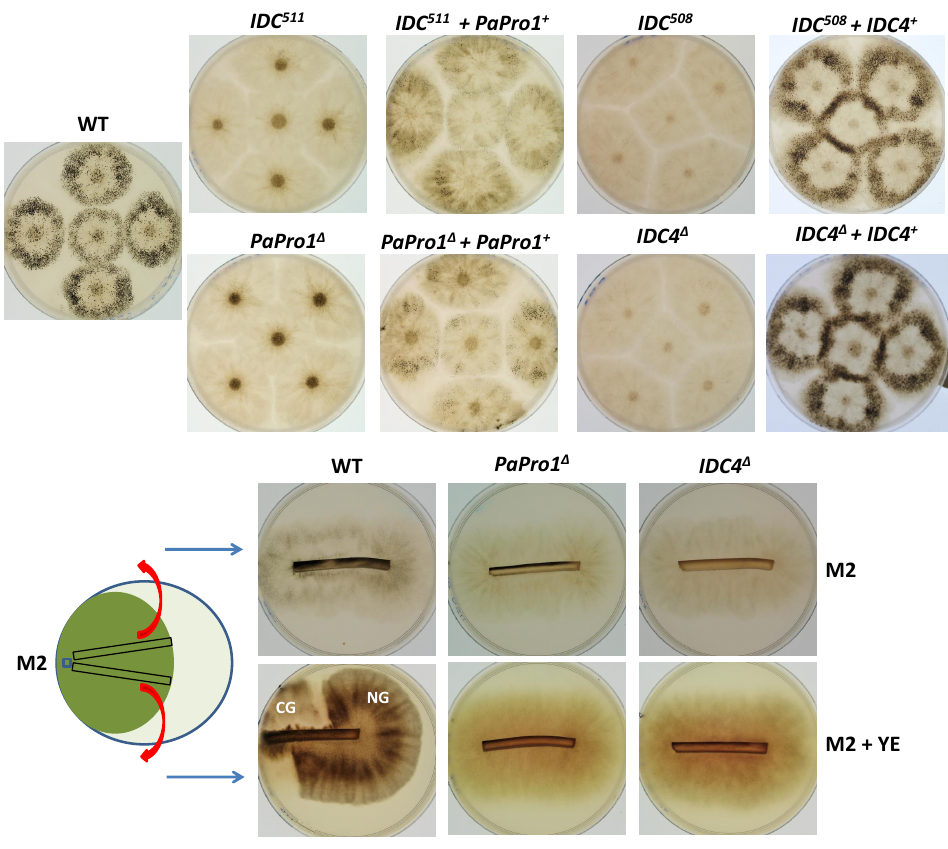
Figure 1. IDC phenotype of PaPro1 and IDC4 mutants. mat +/ mat − heterokaryotic mycelia were inoculated onto M2 medium in Ø = 8 cm Petri plates and incubated for one week, at which time the pictures were taken. The fruiting bodies in the wild type and complemented strains are visible as small black dots. The CG tests at the bottom were made by re-inoculating (red arrows) mycelium slices grown on M2 for seven days and collected as indicated on the left scheme onto fresh media with or without yeast extract. Photos were taken five days after reinoculation. Only the wild type shows CG that originated from hyphae that were in stationary phase. NG, normal